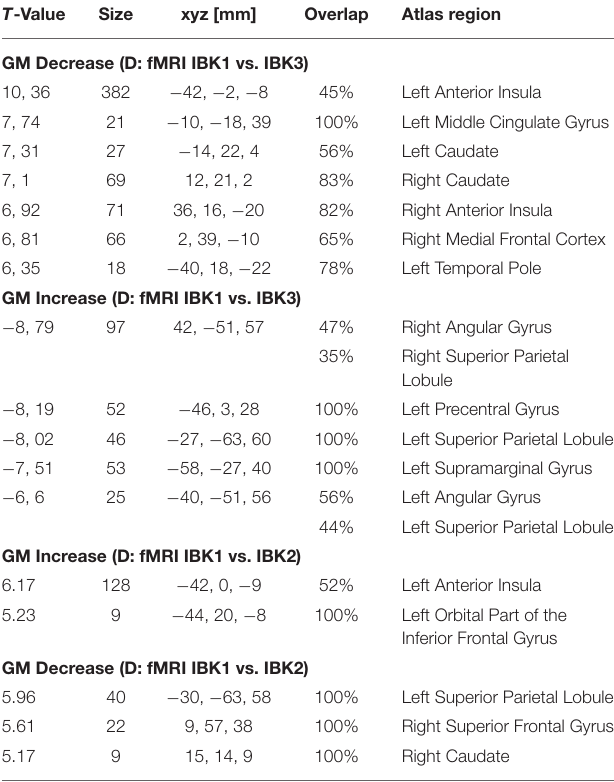
TABLE 3 | MNI-coordinates, maximum T -value, cluster size (in voxel) above threshold and anatomical site ( p < 0.05 FWE-corrected) are reported for GM changes in experiment D of the Innsbruck data